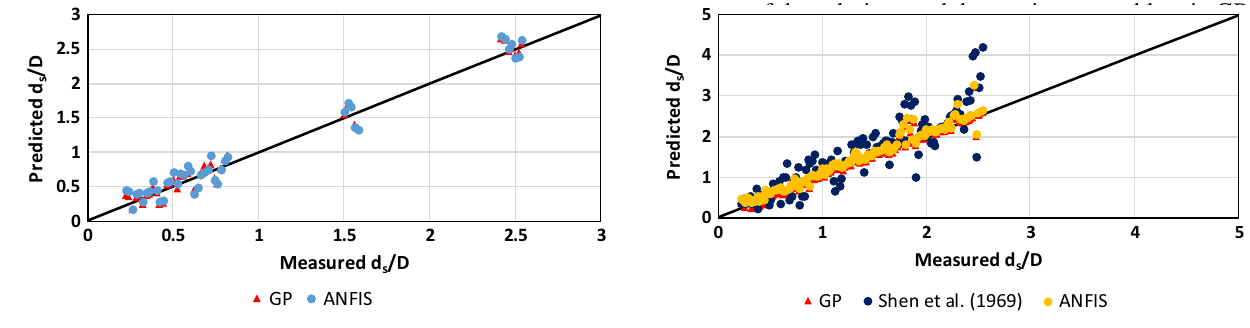
D versus Shen et al. s /